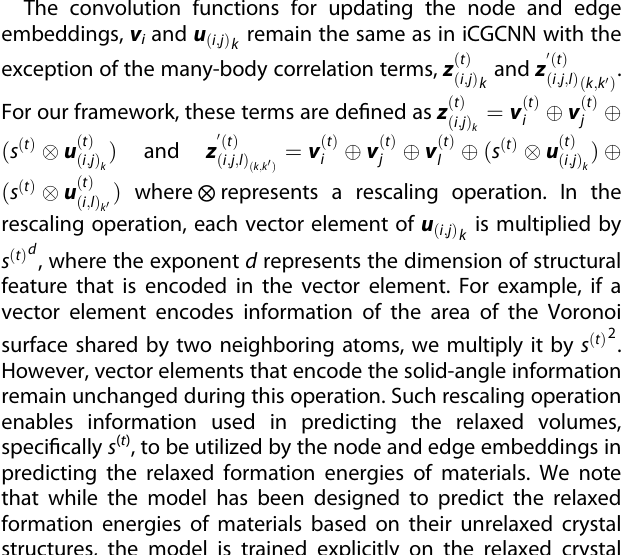
Fig. 1 Schematic design of the machine-learning model. Illustration of the iCGCNN-based multiobjective ML framework that predicts both formation energy and relaxed volume of a crystal. The crystal graph is constructed from the Voronoi tessellated crystal structure that has been normalized to have a minimum interatomic distance of 1. Additional to the node and edge embeddings, v i and u ð i ; j Þ and bond information, the crystal graph is associated with scale factor s that represents the minimum interatomic distance of the crystal. In each iterative convolution step, s is updated as a function of v i such that, at the end of all iterations, the fi nal value s f matches the minimum interatomic distance that would be measured in the crystal structure that has been relaxed with respect to volume. v i and u ð i ; j Þ iteratively updated to better represent the local chemical environment of the crystal. Formation energy is predicted from the fi nal node and relaxed volume of the crystal is calculated by multiplying the cube of s f with the volume of the normalized crystal embedding v f i